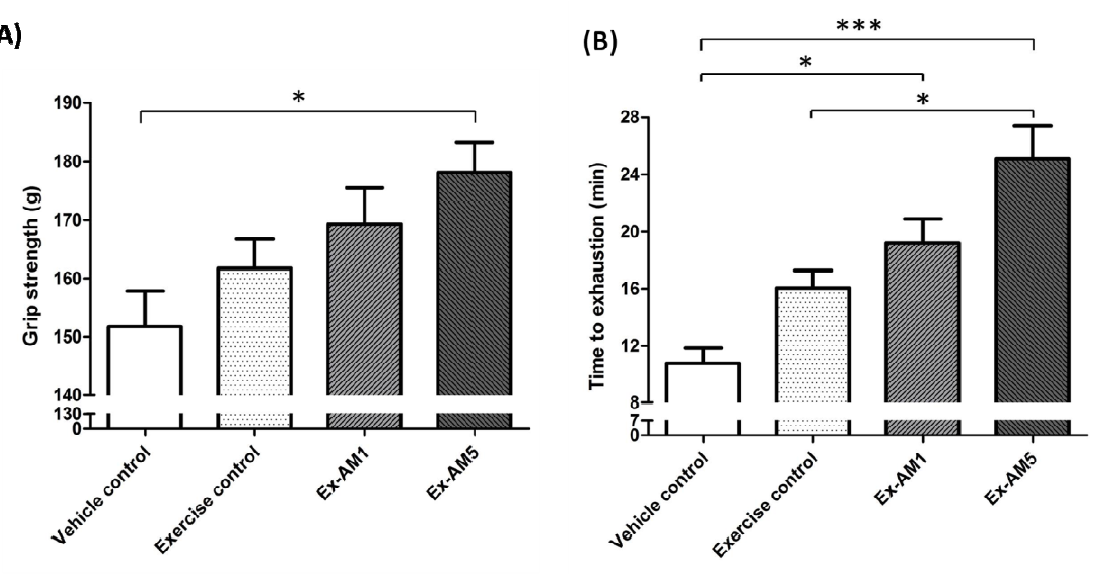
Figure 1. Effect of A. membranaceus (AM) supplementation on forelimb grip strength ( A ) and swimming exercise performance ( B ). Data are mean ± SEM of n = 10 mice in each group by one-way ANOVA. * p < 0.05; *** p <